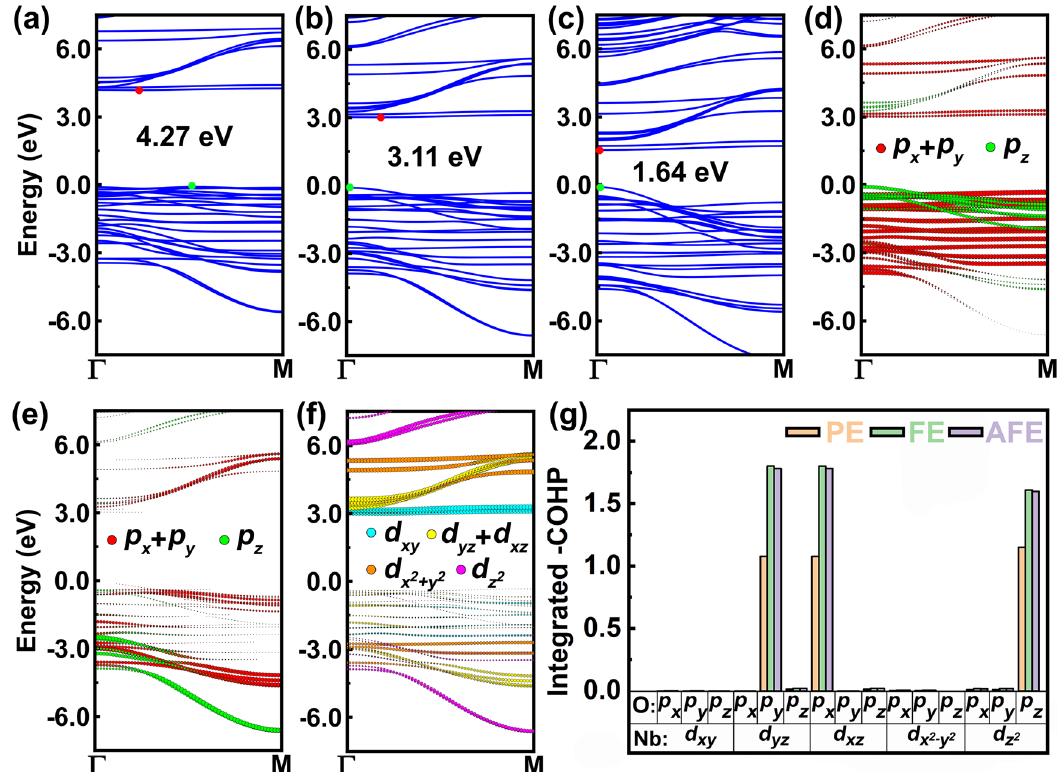
Fig. 3 Band structures and integrated -COHP. a – c The band structures of 1D ferroelectric NbOCl 3 , NbOBr 3 , and NbOI 3 , respectively. The conduction band minimum (CBM) and valence band maximum (VBM) are marked by red and green dots, respectively. d – f The orbital-resolved band structures for Br, O, and Nb in 1D NbOBr 3 , respectively. The radii of the colored dots represent the contribution of the corresponding atomic orbitals. For clarity, the global axes are rotated to align with the NbO 2 Br 4 octahedron, i.e., the x / y and z axes are along the Nb – Br and Nb – O bonding directions, respectively. g The integrated -COHP for all the d - p interactions between Nb and O atoms in PE, FE, and AFE phases of 1D